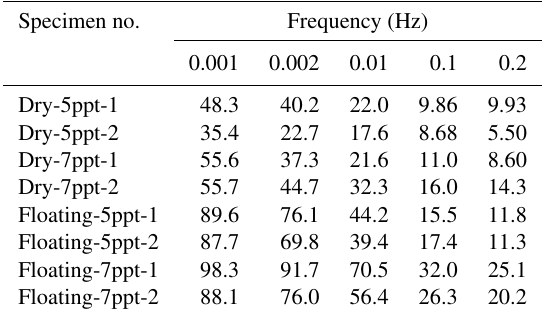
Table 3. The energy dissipation rate (%) in a typical loading– unloading cycle of each